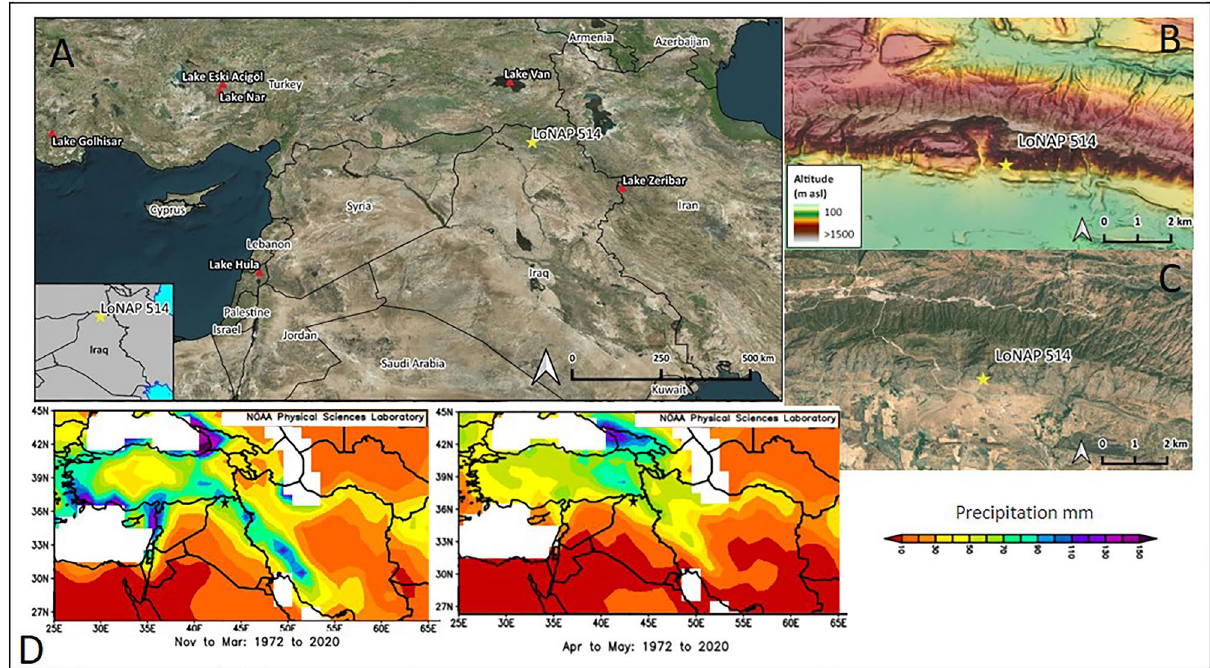
Figure 1. ( A ) Map of the Fertile Crescent region showing the location of the study site (LoNAP 514) and the main regional paleoclimate archives discussed in the text (elaborated with QGIS 3.16.7 plugin https:// nextg is. com/ blog/ quick mapse rvices/); ( B , C ) Digital elevation model (DEM) and satellite imagery of the northern Kurdistan region of Iraq (DEM free downloaded from https:// www. eorc. jaxa. jp/ ALOS/ en/ aw3d30/ and elaborated with QGIS 3.16.7; satellite imagery elaborated with QGIS 3.16.7 plugin https:// nextg is. com/ blog/ quick mapse rvices/); ( D ) Maps of mean monthly precipitation in winter and spring (downloaded from https:// psl. noaa. gov/). The star is the LoNAP514